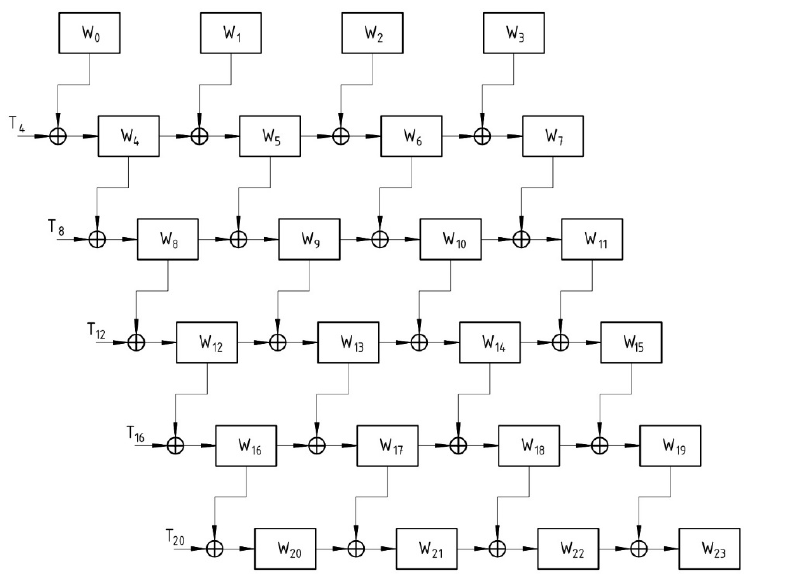
Figure 3. FJMKE for AES-128.